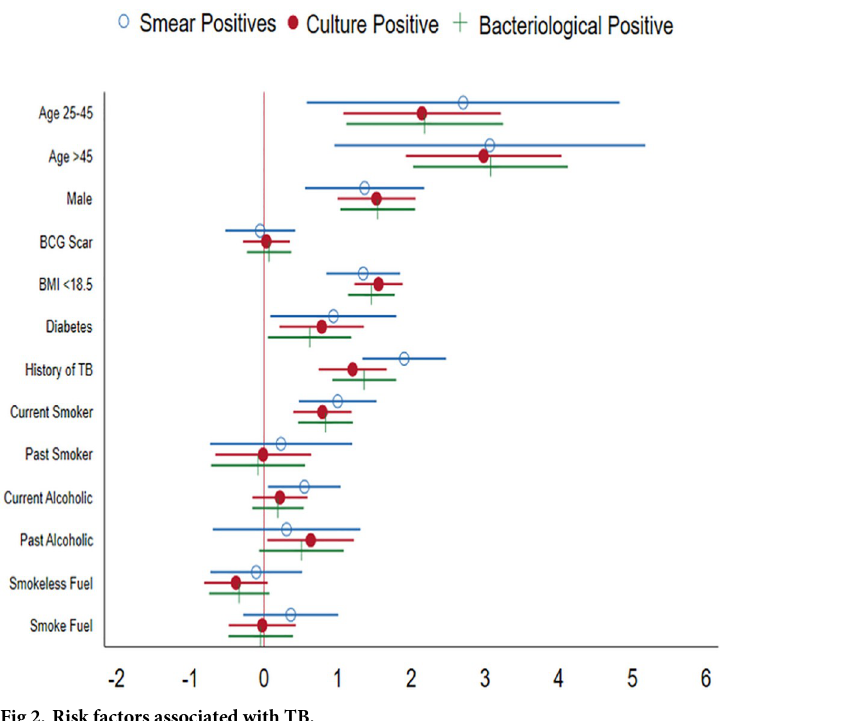
Fig 2. Risk factors associated with